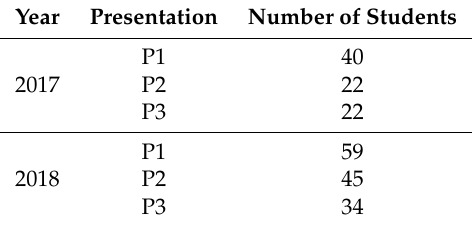
Table 2. Number of observations of each